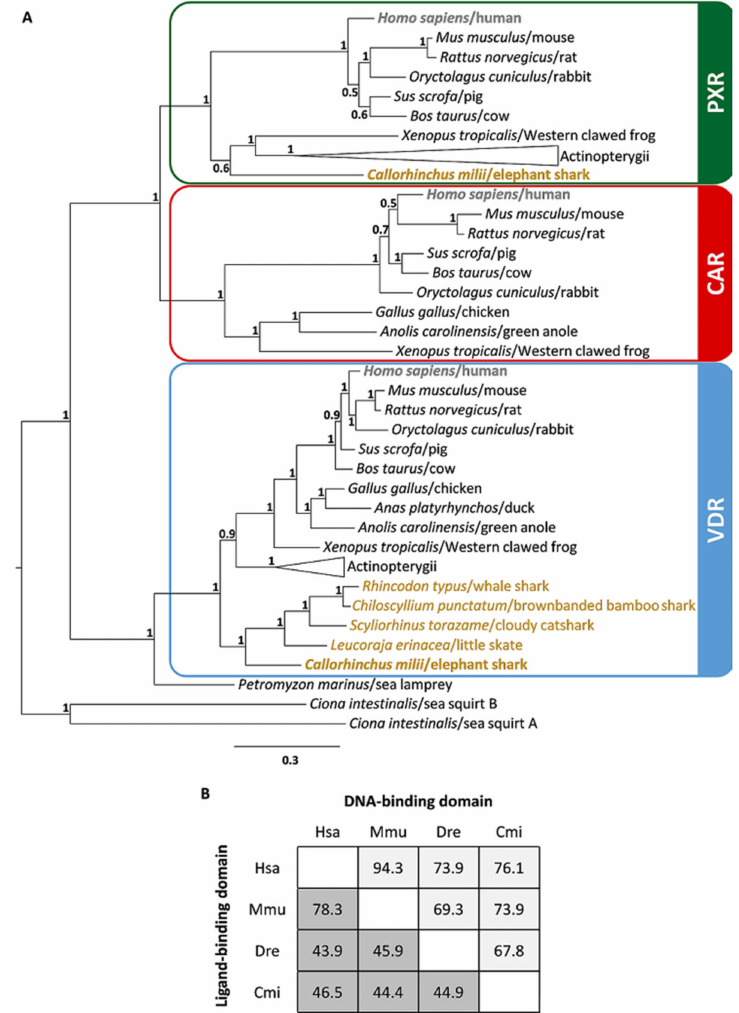
Figure 1. The NR1I gene repertoire in Chondrichthyes. ( A ) Bayesian phylogenetic tree of vitamin D receptor ( VDR ), pregnane X receptor ( PXR ) and constitutive androstane receptor ( CAR ) genes. The numbers at the nodes represent the statistical support expressed in Bayesian posterior probabilities. Actinopterygii are represented by Danio rerio (zebrafish), Cyprinus carpio (European carp), Oryzias latipes (medaka), Oreochromis niloticus (Nile tilapia), Scleropages formosus (Asian arowana), and Lepisosteus oculatus (spotted gar). Chondrichthyes are highlighted in yellow: Elasmobranchii (little skate, brownbanded bambooshark, whale shark and cloudy catshark) and Holocephali (elephant shark) in bold. ( B ) Percentage of amino acids, identity of DNA, and ligand binding domains between human (Hsa), mouse (Mmu), zebrafish (Dre), and elephant shark (Cmi)